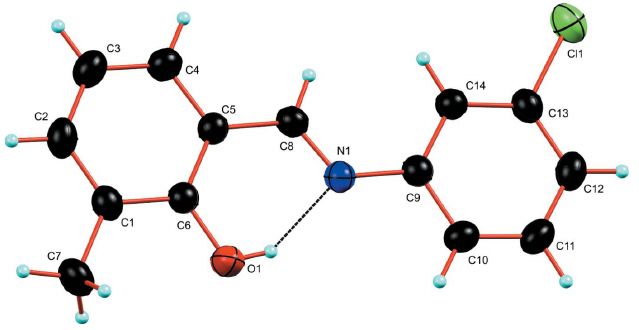
Figure 1 A view of the molecular structure of (I) with the atom labelling. The dotted line indicates the intramolecular O—H (cid:2)(cid:2)(cid:2) N hydrogen bond. Displacement ellipsoids are shown at the 40% probability